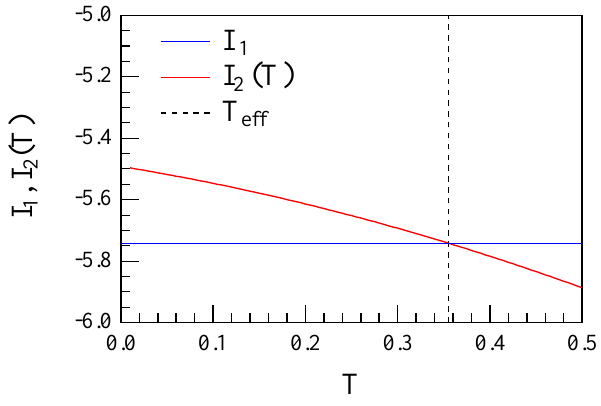
Fig. 6. Plot of I 1 and I 2 (T ) in the case of the total data set and choosing 1AU PDF as the reference one ( f 0 ). The intersection be- tween I 1 and I 2 (T ) provides the value of the effective temperature T eff that solves Eq. (16) – vertical dashed line.